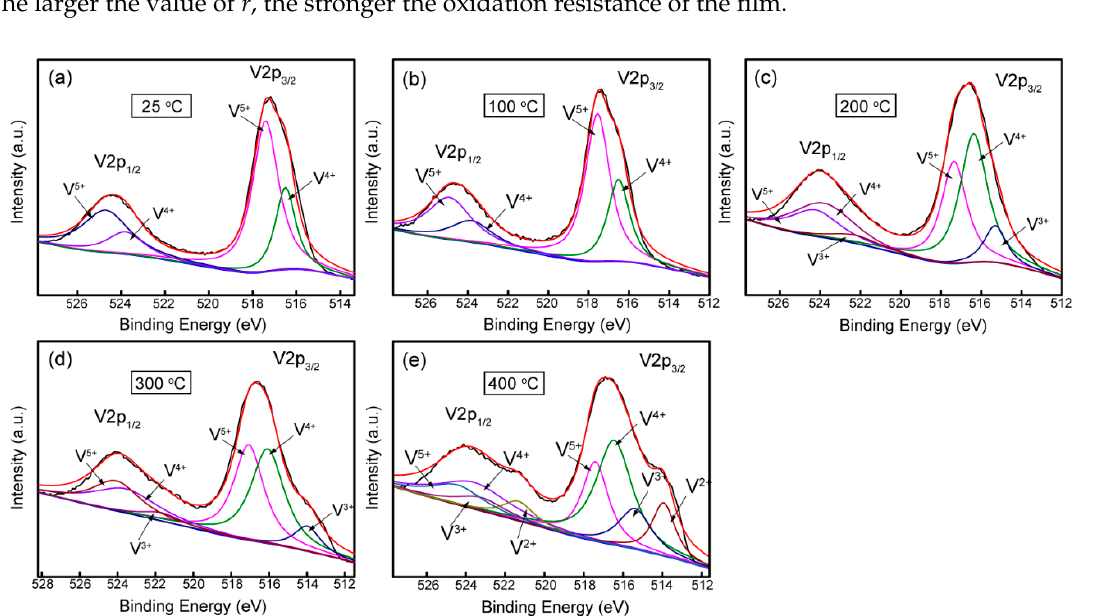
Figure 10. ( a ) Cross-sectional TEM image of the V film deposited on Si (100) at T s = 400 °C and D t-s = 60 mm and SAED pattern of the yellow square area in insert, ( b ) TEM image of the yellow square area in ( a ), ( c ) HRTEM image and Fast Fourier Transform (FFT) of region I, ( d ) HRTEM image and Fast Fourier Transform (FFT) of region II.